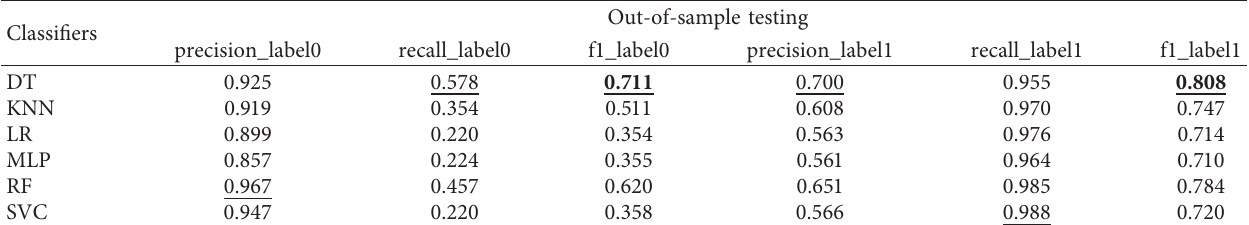
Table 6: Out-of-sample testing of models with feature augmentation.